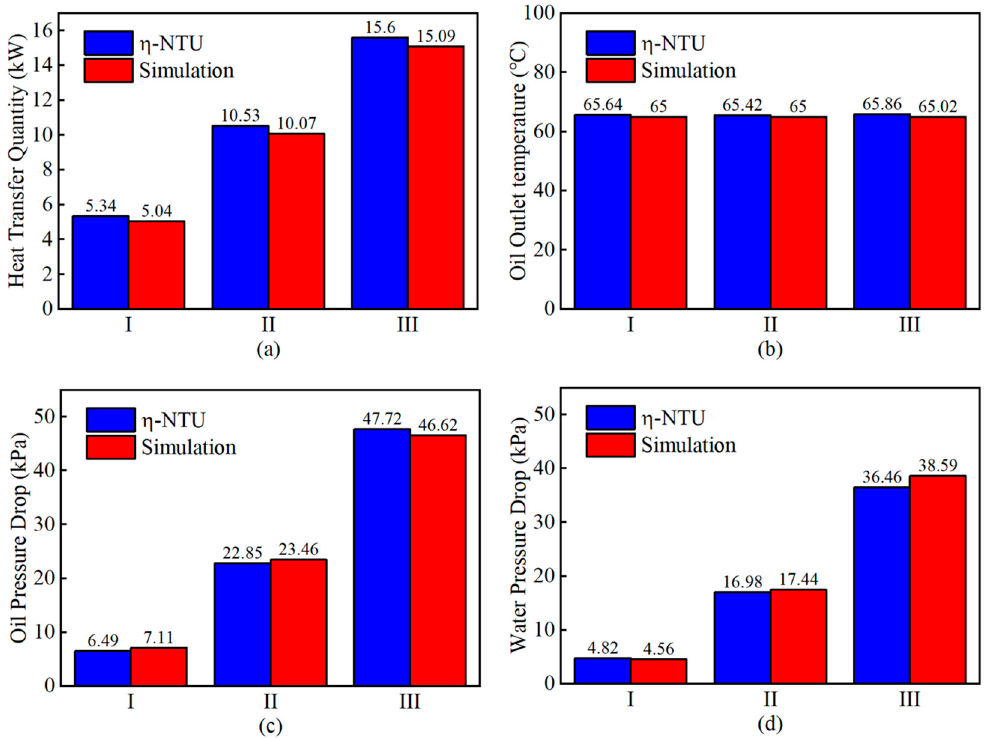
Figure 4. Comparison of η -NTU calculation results and simulation results: ( a ) Heat transfer quantity, ( b ) Oil outlet temperature, ( c ) Oil pressure drop, ( d ) Water pressure drop.